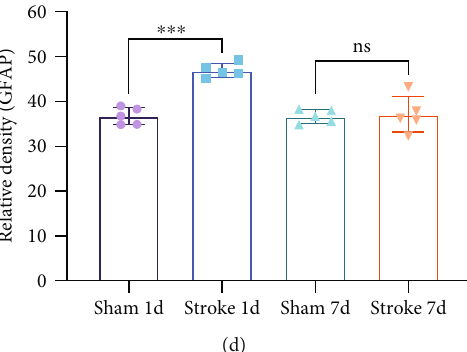
Figure 5: Ischemic stroke activated enteric glia. (a, b) Representative western blots and quanti fi cation data of GFAP and GAPDH for each group ( n = 5 ). (c) Representative fl uorescence microscopic images of GFAP (green) and DAPI (blue) (magni fi cation × 100). Both images are merged at the top panel. (d) Quanti fi cation of GFAP punctae ( n = 5 ). Data were expressed as mean ± standard deviation . ∗∗ p < 0 : 01 , ∗∗∗ p < 0 : 001 (two-way ANOVA, Tukey ’ s posttest). ns: not signi fi cant. Scale bar: 200 μ m.